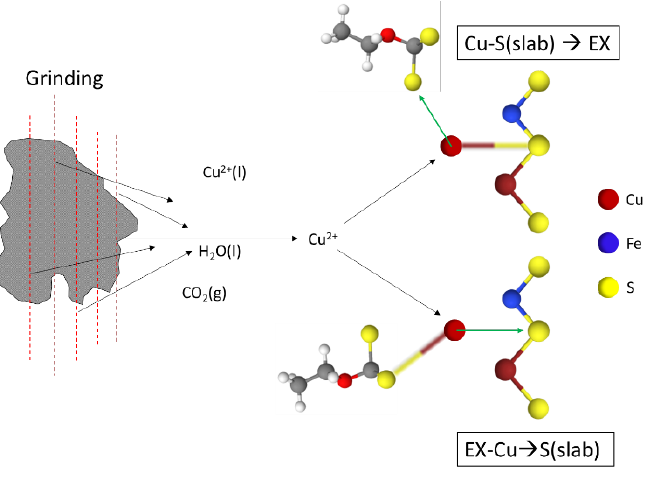
Figure 14. Induced activation of the flotation pathways of the copper ions released by the inclusion of fluids. EX = Ethyl xanthate (adapted from Wen et al. [45]).